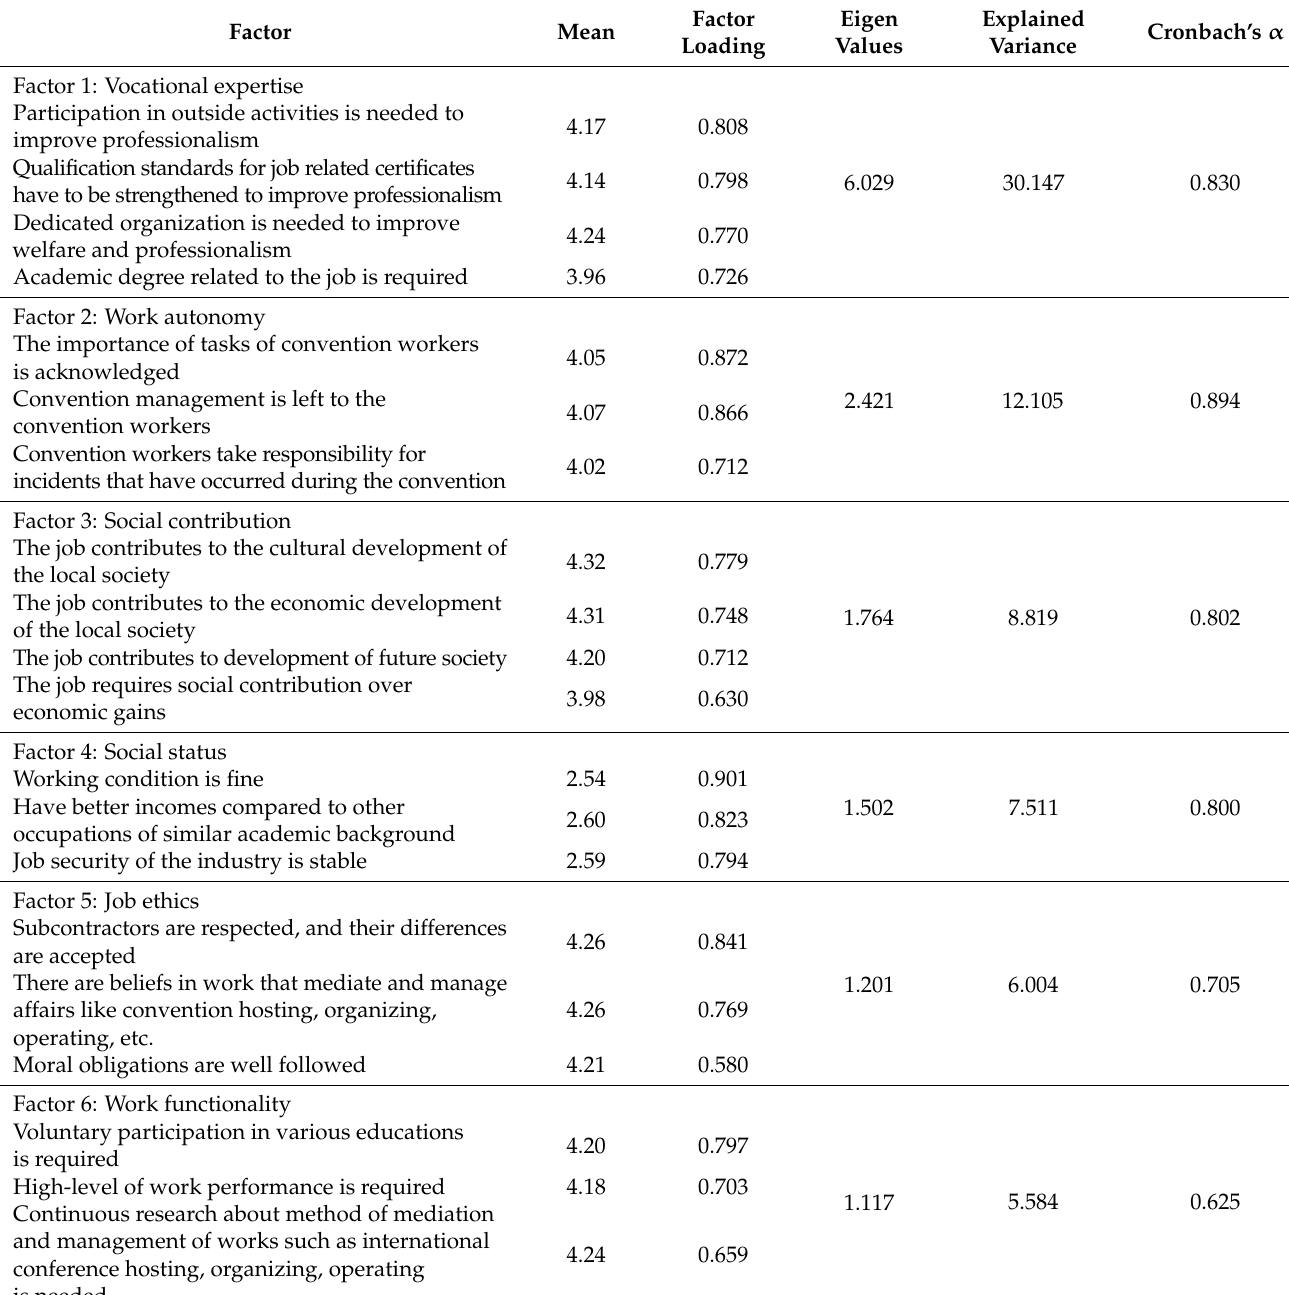
Table 2. Results of factor analysis for Professionalism perception